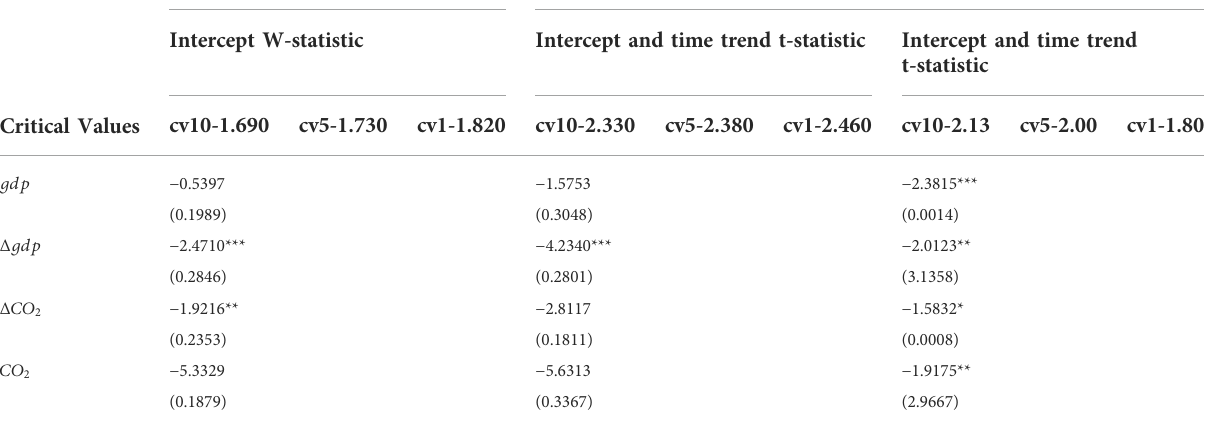
TABLE 2 Linear and nonlinear unit root tests.